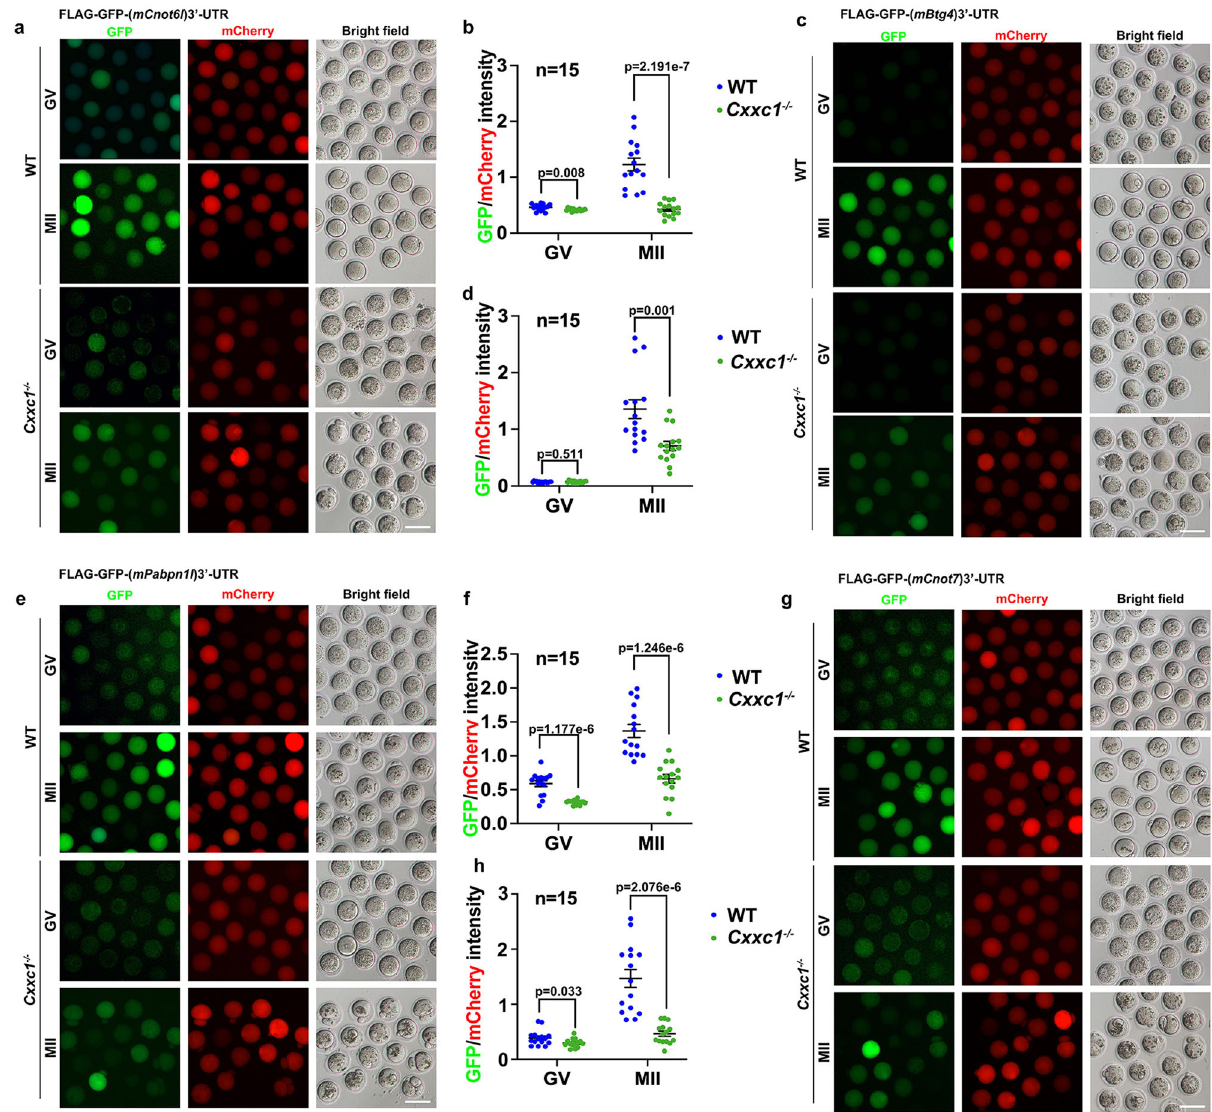
Fig. 9 Translational activities of transcripts encoding factors related to maternal mRNA clearance in oocytes of 4-week-od WT or Cxxc1 -deleted mice. Fluorescence microscopy results ( a ) and quanti fi cation of the fl uorescent signals ( b ) showing the translation activities of the Cnot6l 3 ′ -UTR in GV or MII oocytes of 4-week-old WT or Cxxc1 fl / fl ;Gdf9-Cre mice. c , d Fluorescence ( c ) and quanti fi cation ( d ) showing the translation activities of the Btg4 3 ′ -UTR in GV or MII oocytes of 4-week-old WT or Cxxc1 fl / fl ;Gdf9-Cre mice. Fluorescence ( e ) and quanti fi cation ( f ) showing the translation activities of the Pabpn1l 3 ′ - UTR in GV or MII oocytes of 4-week-old WT or Cxxc1 fl / fl ;Gdf9-Cre mice. g , h Fluorescence ( g ) and quanti fi cation ( h ) showing the translation activities of the Cnot7 3 ′ -UTR in GV or MII oocytes of 4-week-old WT or Cxxc1 fl / fl ;Gdf9-Cre mice. Scale bar = 100 µ m ( a , c , e , g ). In b , d , f and h , data are presented as mean values ± SEM. P by two-tailed Student ’ s t -test. n.s.: non-signi fi